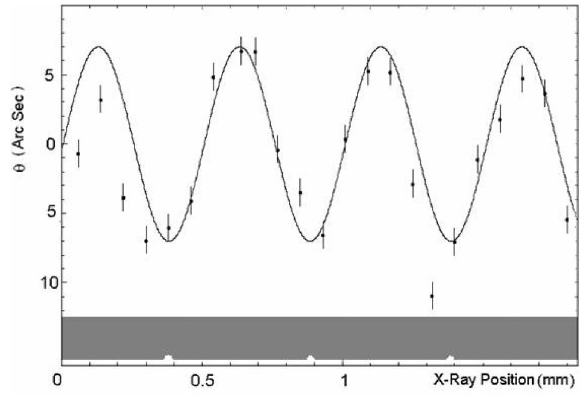
FIG. 4. X-ray test of one of the